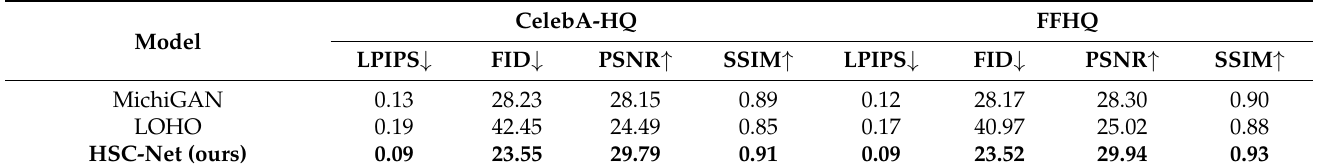
Table 3. Comparison of CelebA-HQ and FFHQ data with other models using GAN performance evaluation metrics, including LPIPS, FID, PSNR, and SSIM.